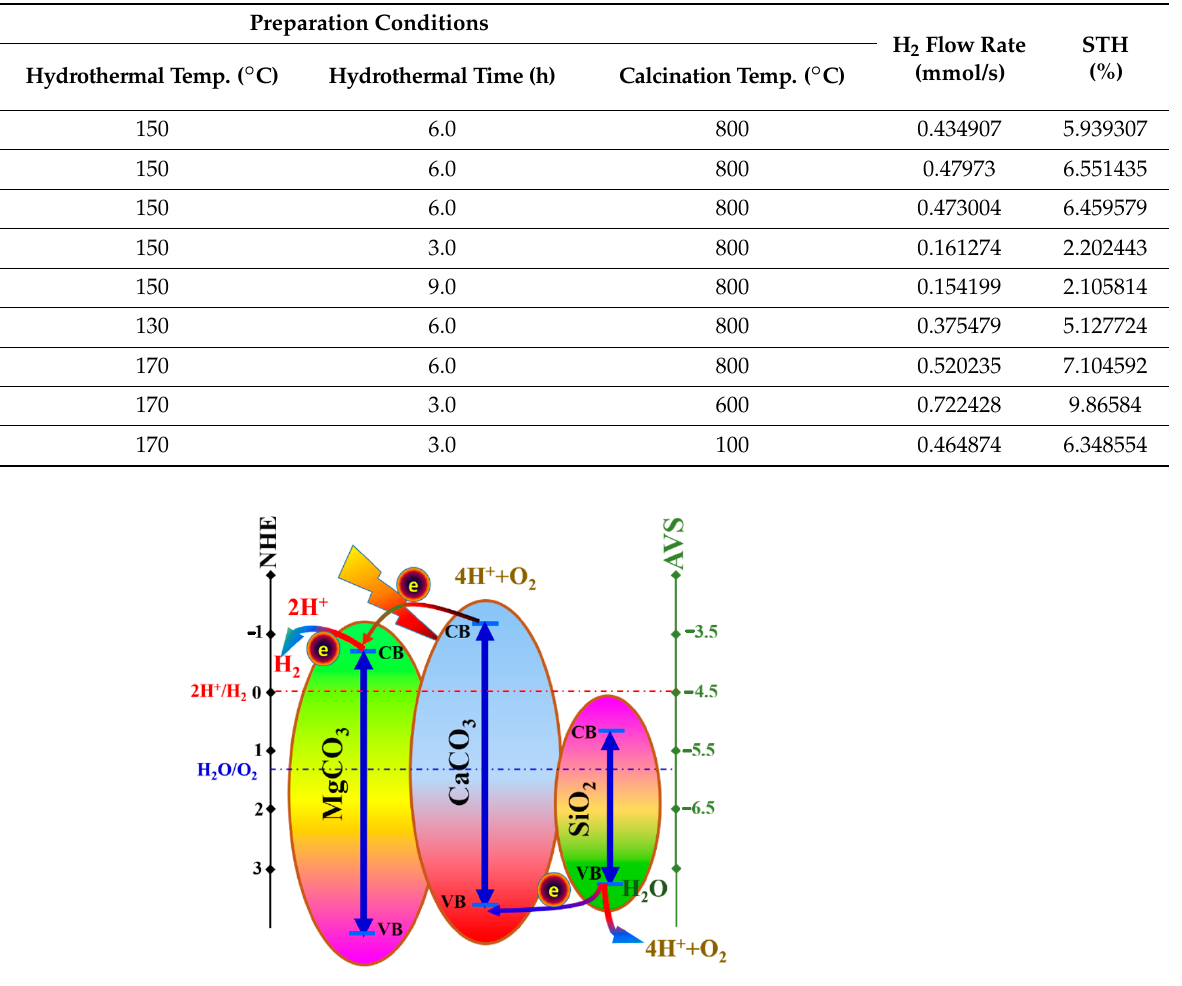
Table 3. STH values for the prepared nanocomposites photocatalysts prepared under different conditions.